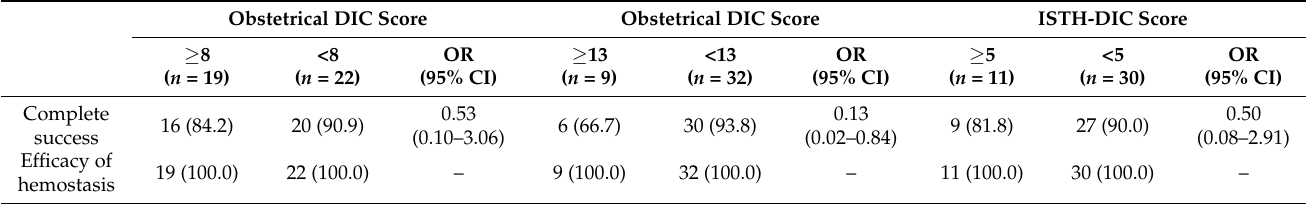
Table 6. Comparison of clinical outcomes of patients who underwent TAE for PPH complicated with or without DIC. Obstetrical DIC Score Obstetrical DIC